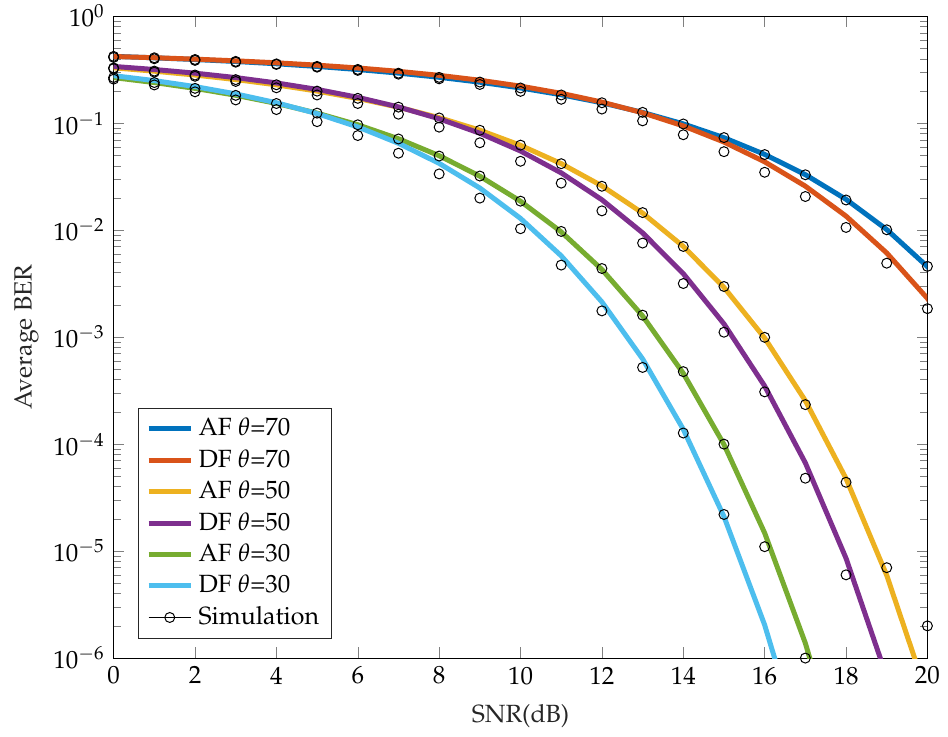
Figure 4. Comparison of average BER for different irradiance angle with constant FOV.